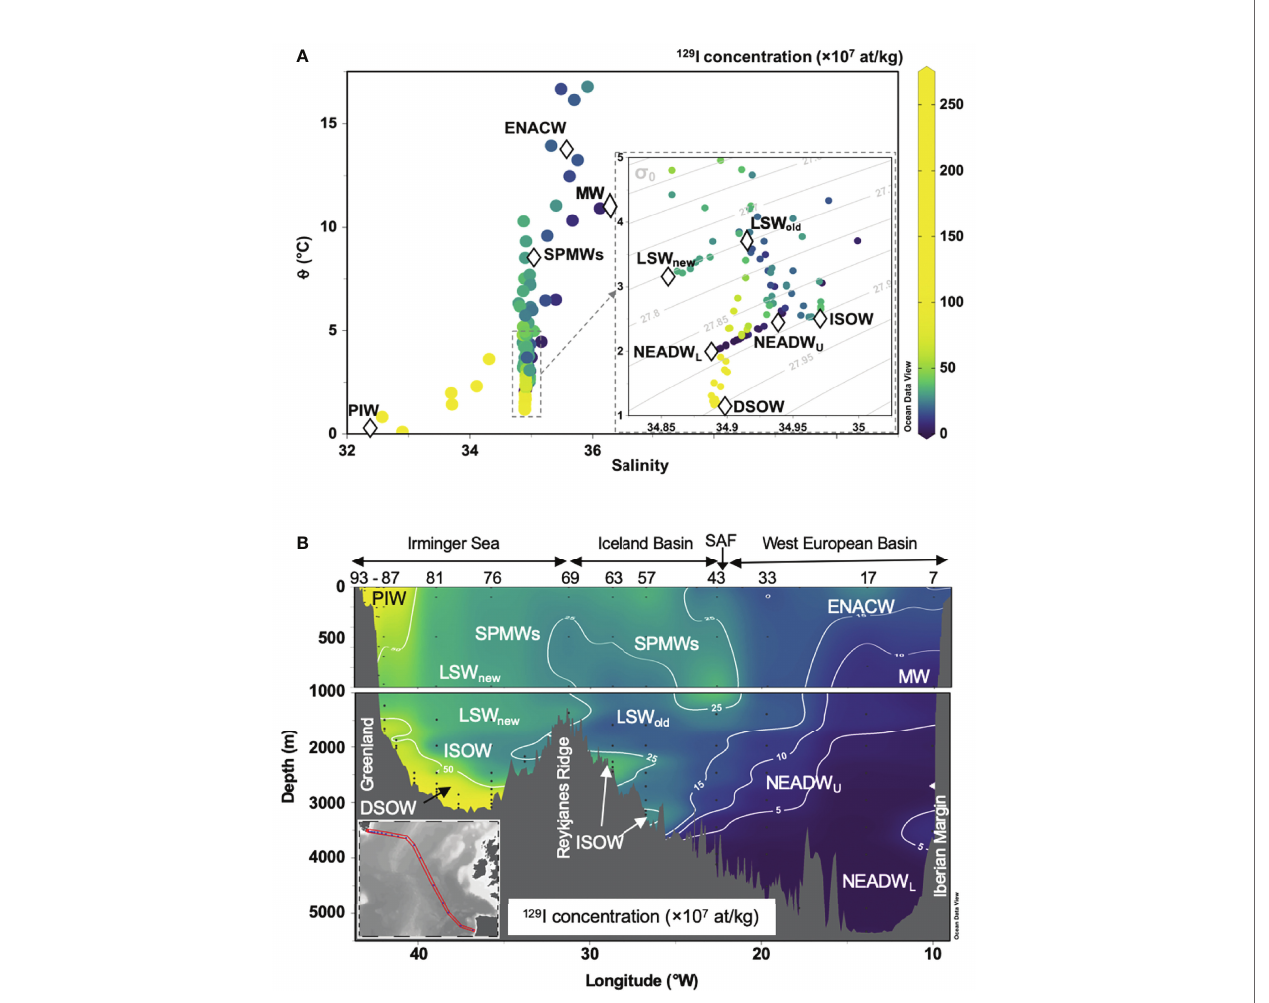
FIGURE 3 | Relationship of 129 I with water masses in the SPNA. (A) Potential temperature ( q ) – salinity diagrams. The color bar indicates the 129 I concentrations. (B) Zonal section of 129 I concentrations. The color coding is the same as for (A) . The acronyms of the water masses shown in (A) are also represented in (B) . Data correspond to the OVIDE cruise in 2018. Acronyms in fi gure: Denmark Strait Over fl ow Water, (DSOW); East North Atlantic Central Water, (ENACW); Iceland Scotland Over fl ow Water, (ISOW); Labrador Sea Water, (LSW); Mediterranean Water, (MW); North East Atlantic Deep Water, (NEADW, lower and upper); Polar Intermediate Water, (PIW); Sub-Arctic Front, (SAF); Subpolar Mode Water,